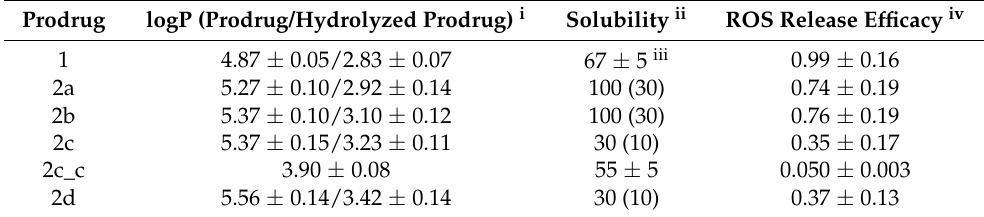
Table 1. Selected properties of the prepared prodrugs and the control 1.